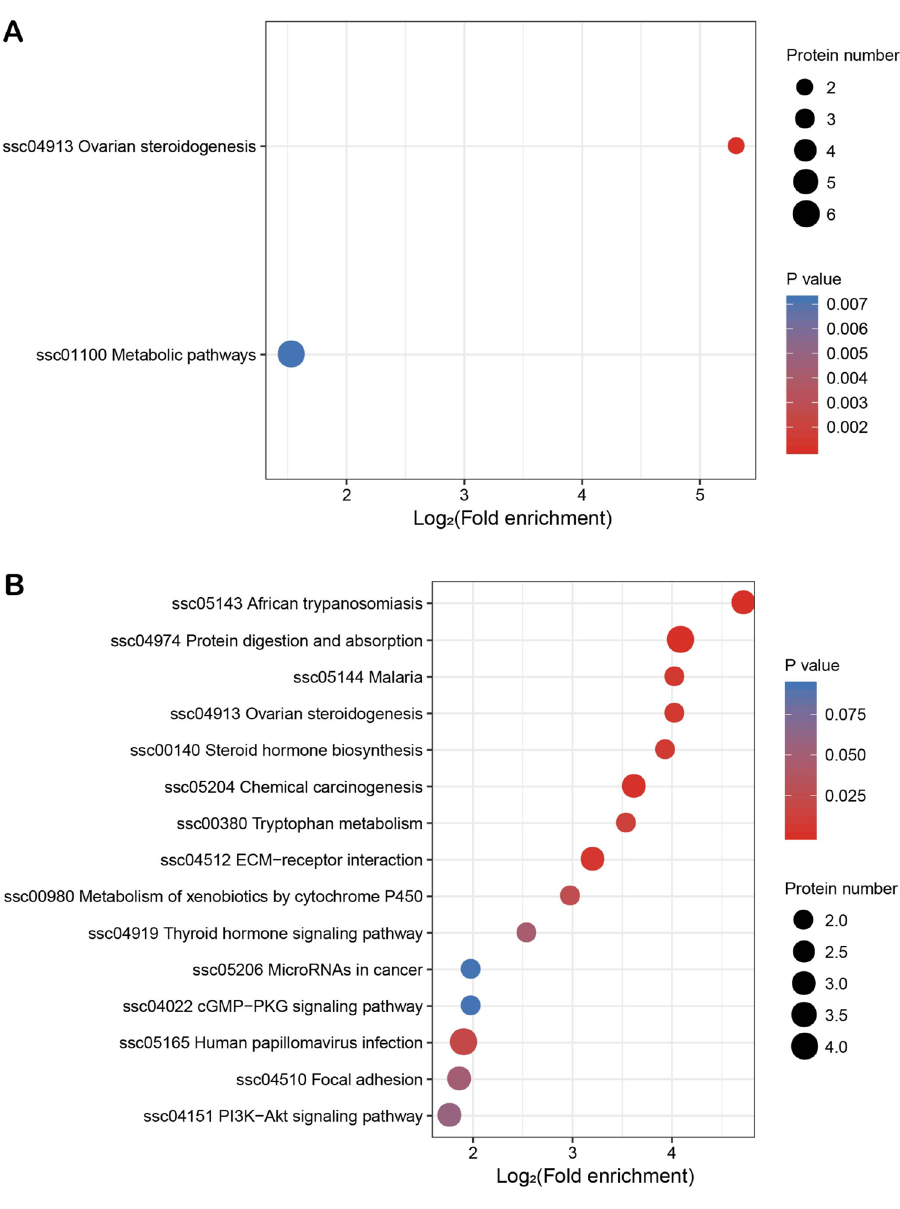
Figure 6. KEGG pathway enrichment bubble plot of differentially abundant proteins (DAPs). ( A ) S2 vs S1; ( B ) S3 vs S1; ( C ) S4 vs S1. The bubble chart gives the results of the top 20 classifications with the most significant enrichment. The vertical axis is the functional classification or pathway, and the horizontal axis is a log2 converted value of the proportion of differential proteins in this functional type compared to the multiple of the proportion of identified proteins. The circle color indicates enrichment significance (p-value), circle size indicates the number of differential proteins in functional classes or pathways. S1: control diet; S2: control diet supplemented with 1 μg/kg 1α,25(OH) 2 VD 3 ; S3: control diet supplemented with 2 μg/kg 1α,25(OH) 2 VD 3 ; S4: control diet supplemented with 4 μg/kg 1α,25(OH) 2 VD 3. 1α,25(OH) 2 VD 3 was provided as 1α,25(OH) 2 VD 3 - glycosides from plant